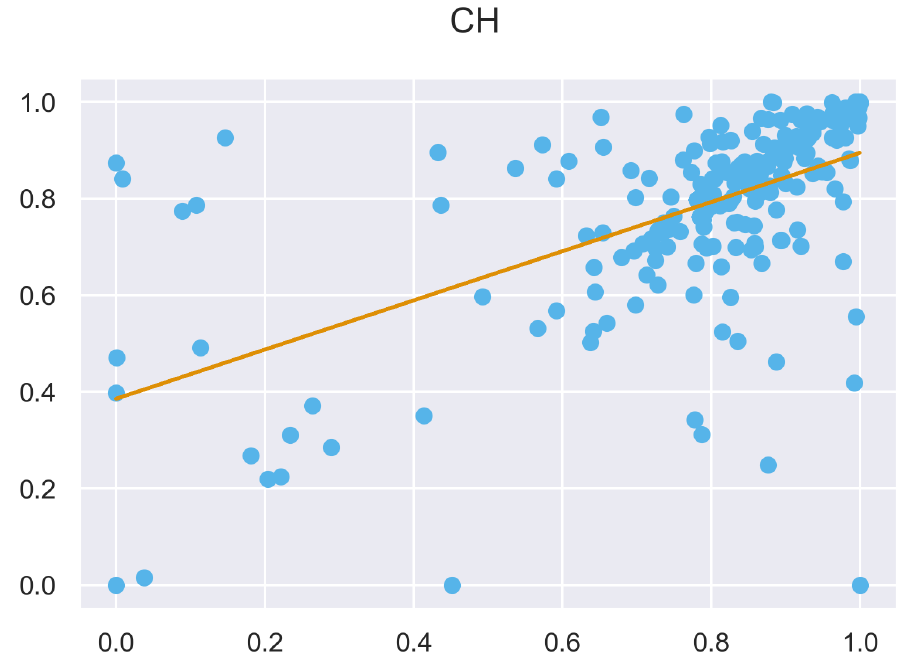
Figure A46. ULS and TLS CH regression at 5m grid